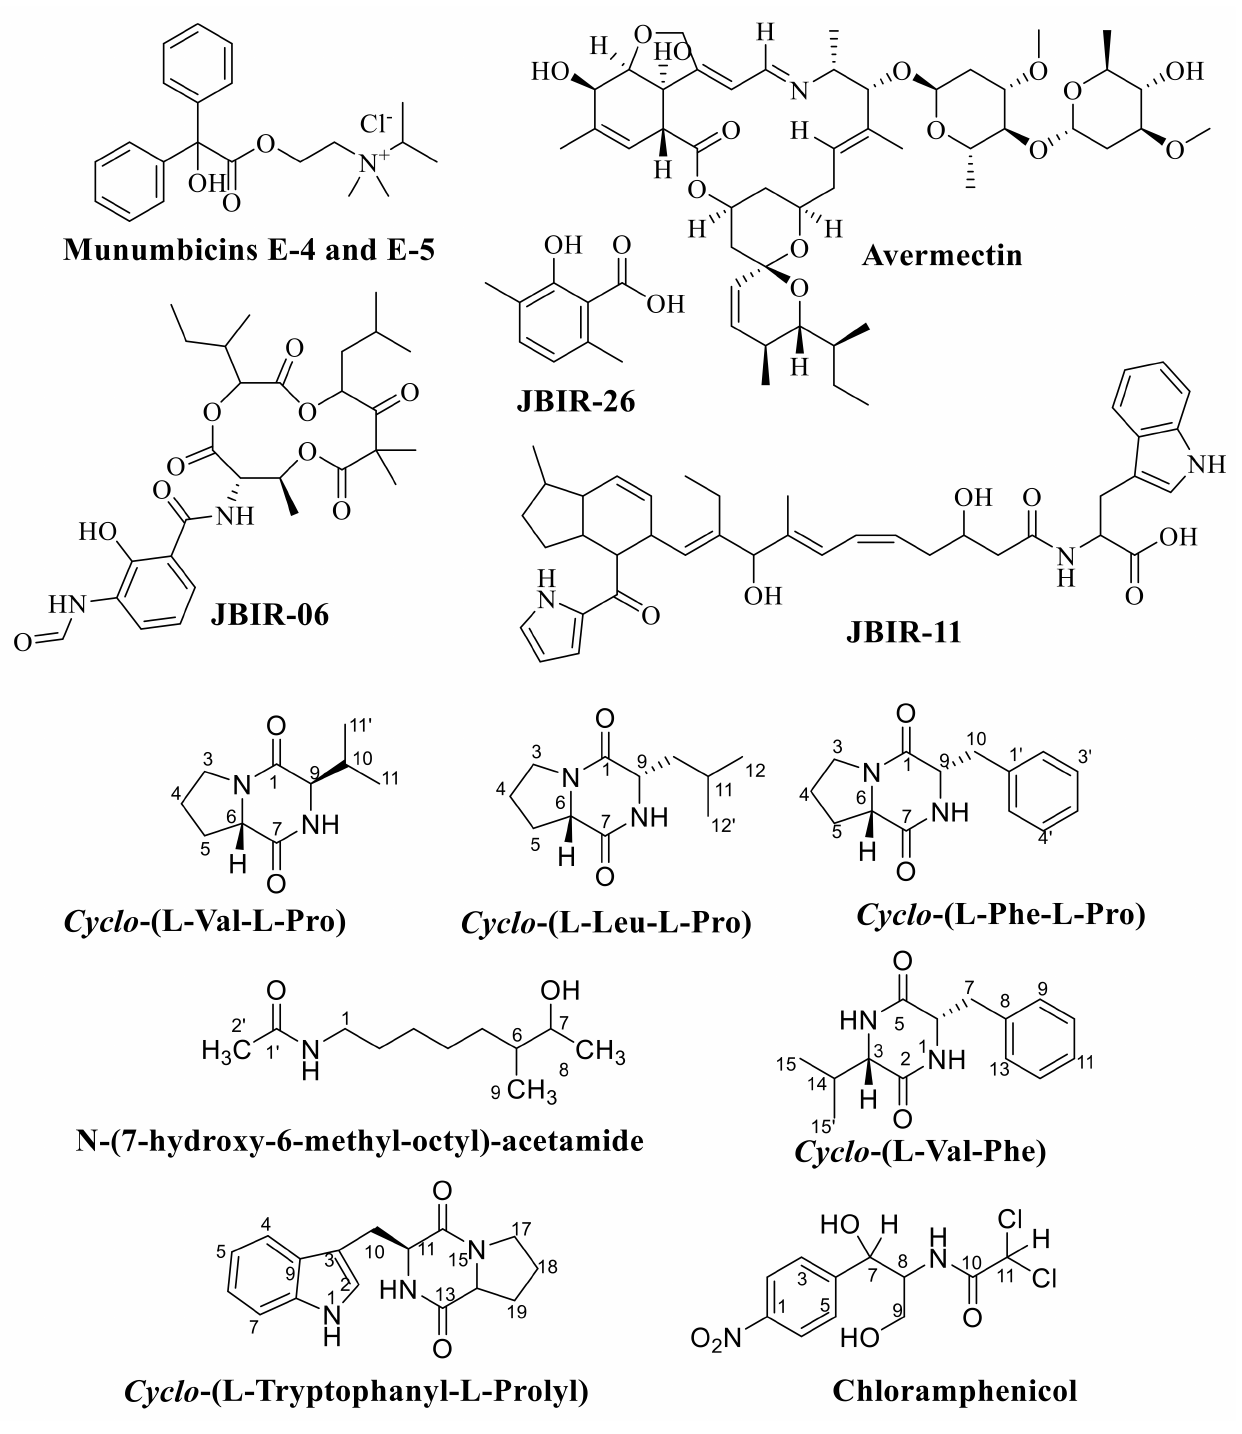
Figure 5. The molecular structure of Munumbicins E-4 and E-5; Avermectin; JBIR-06; JBIR-11; and JBIR-26. Cyclo - (L-Val-L-Pro), Cyclo -(L-Leu-L-Pro), Cyclo -(L-Phe-L-Pro), N-(7-Hydroxy-6-Methyl-Octyl)-Acetamide, Cyclo -(L-Val-L-Phe), Cyclo -(L-Tryptophanyl-L-Prolyl) and